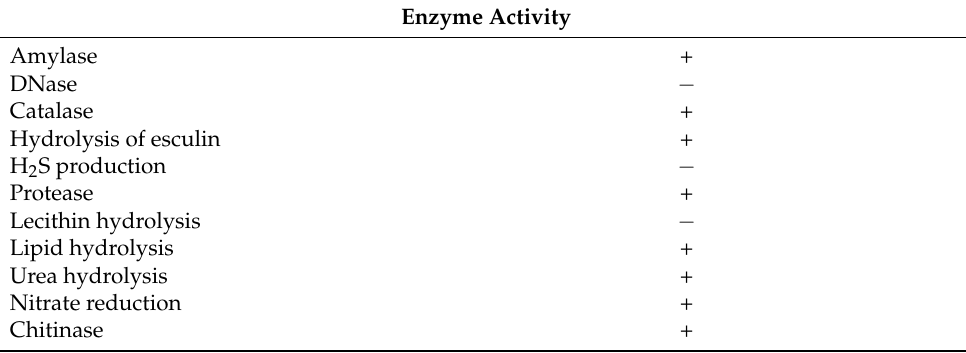
Table 3. Different enzyme activities of Streptomyces sp. strain ess_amH1.